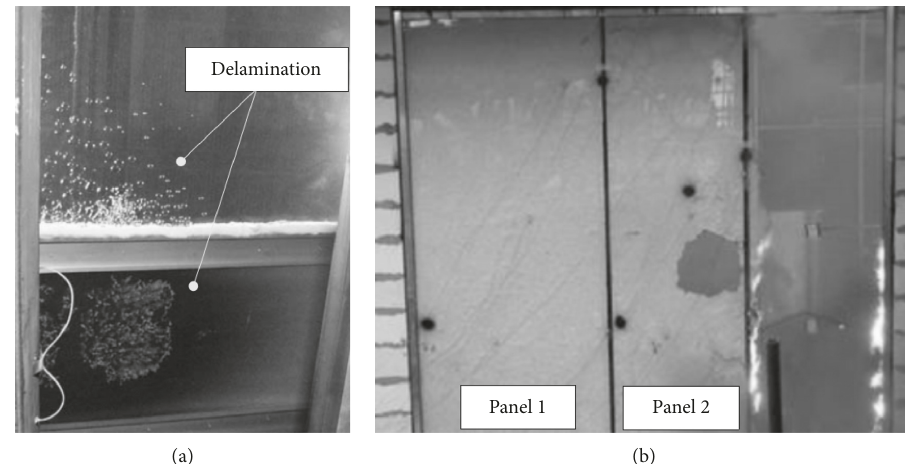
Figure 9: Glass enclosures under fire. (a) Evidence of partial delamination, as reported in [60] and (b) full-scale glazing wall tested in [70]. In evidence, it is possible to notice the loss of wall integrity and initiation of gel melting, after 49 minutes of fire